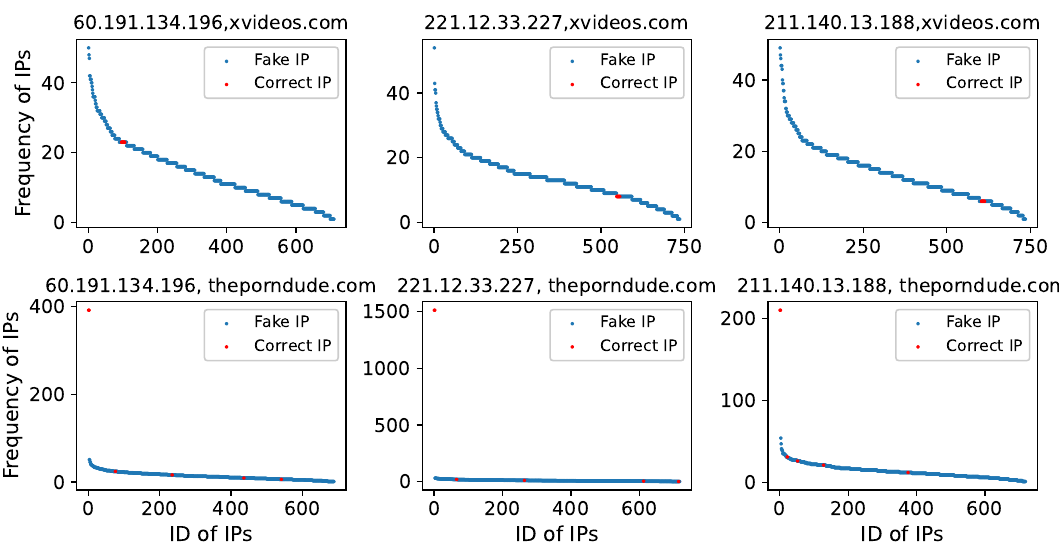
Figure 19. The frequency with which Chinese pDNS respond to correct and forged IPs for the domain xvideos.com.